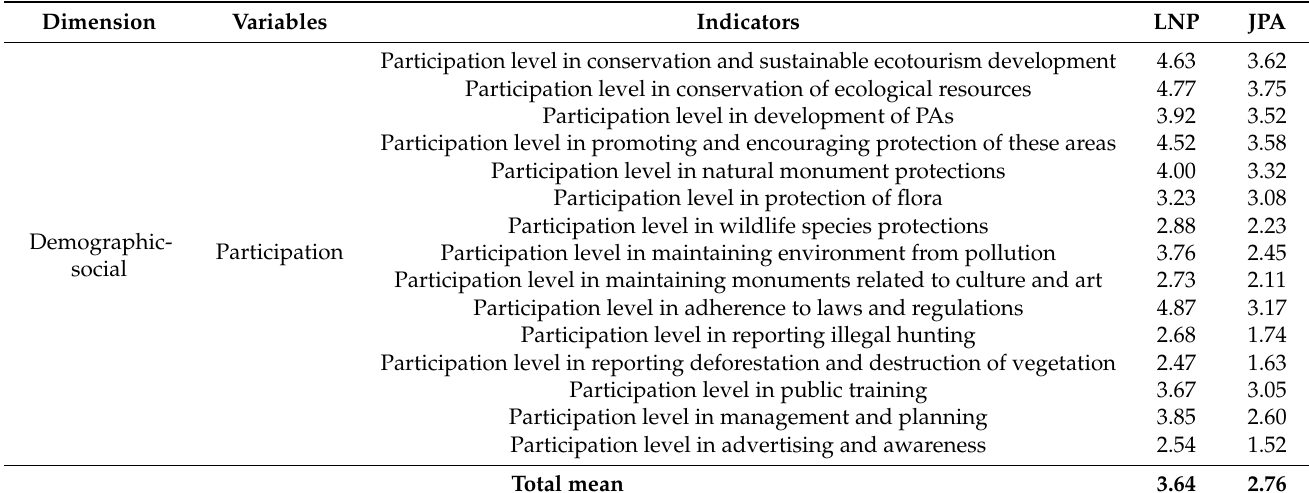
Table 2. Evaluation of local community participation in two protected areas in Iran.